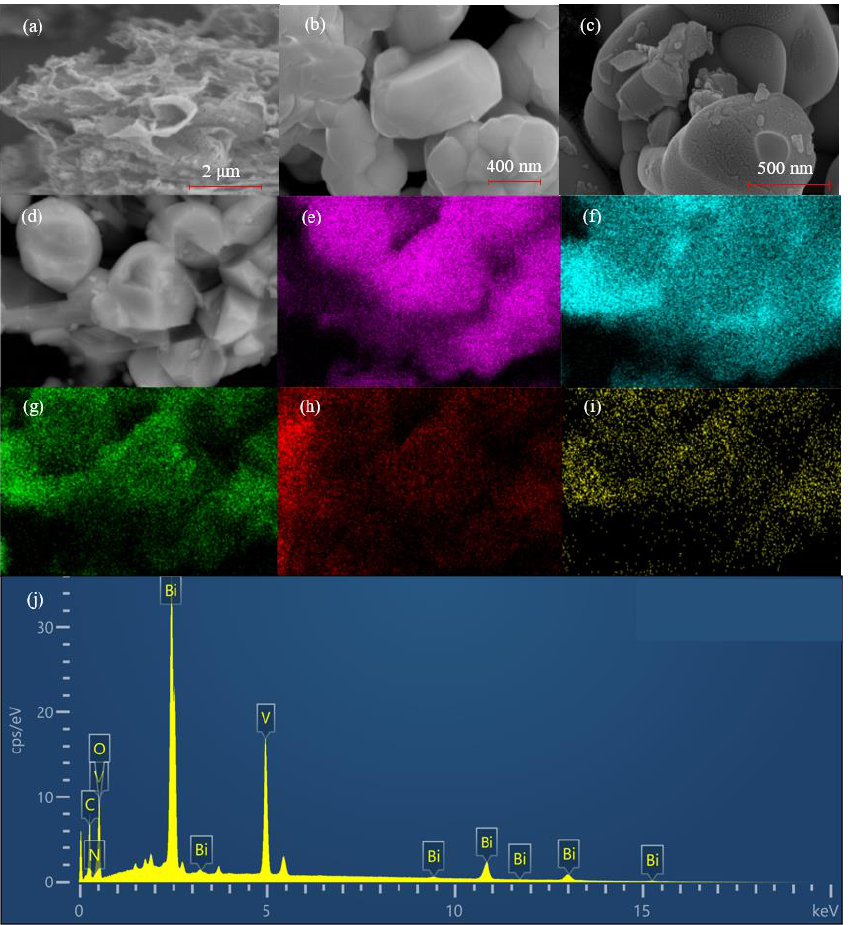
Figure 2. SEM image of ( a ) CN, ( b ) BVO, and ( c ) 1.0-CN/BVO; elemental mapping of 1.0-CN/BVO composite: ( d ) SEM image of 1.0-CN/BVO, ( e ) Bi, ( f ) O, ( g ) C, ( h ) V, ( i ) N, ( j ) EDS of 1.0-CN/BVO.